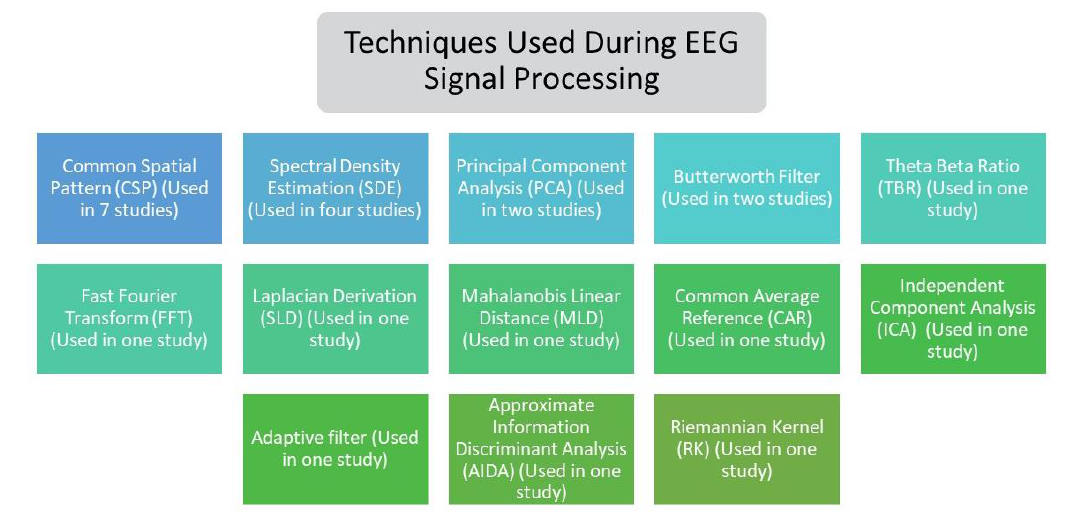
Figure 5. Techniques applied during EEG signal processing of the included proposals.